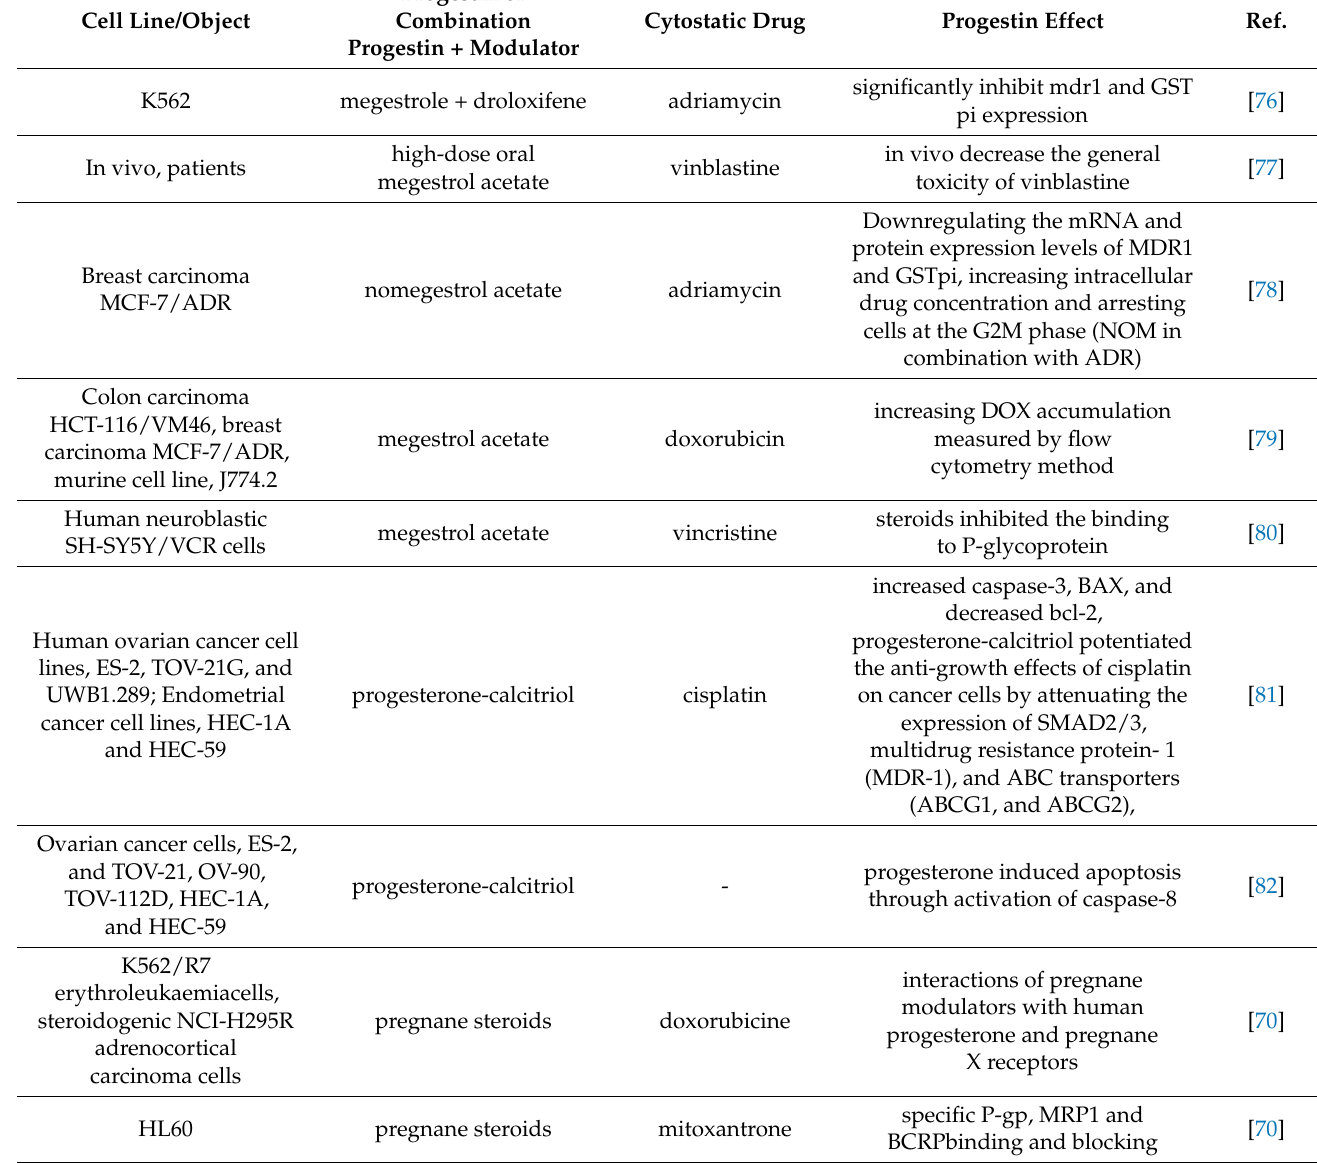
Table 3. Progestins modulating MDR in experimental